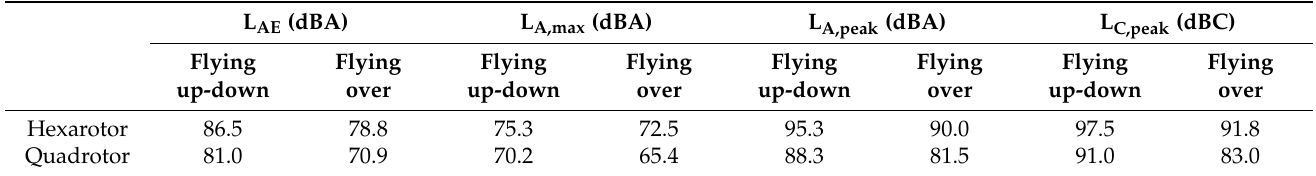
Table 3. Overall measurement